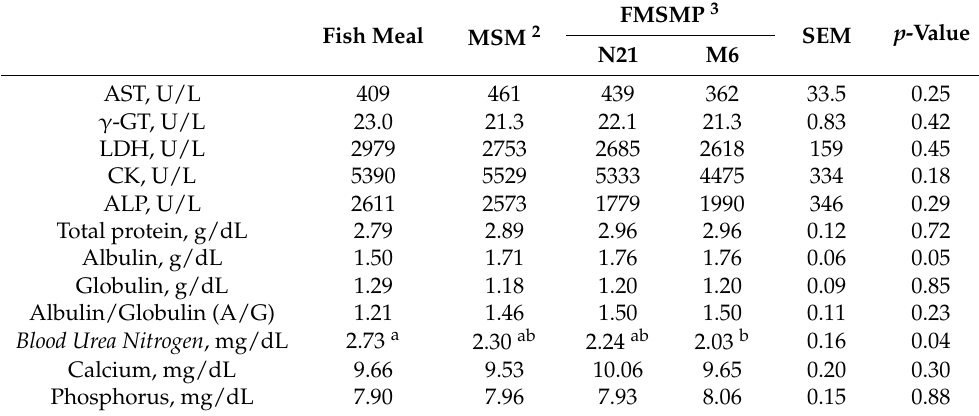
Table 10. Effect of different FMSMPs on serum biochemical constituents in broilers 1